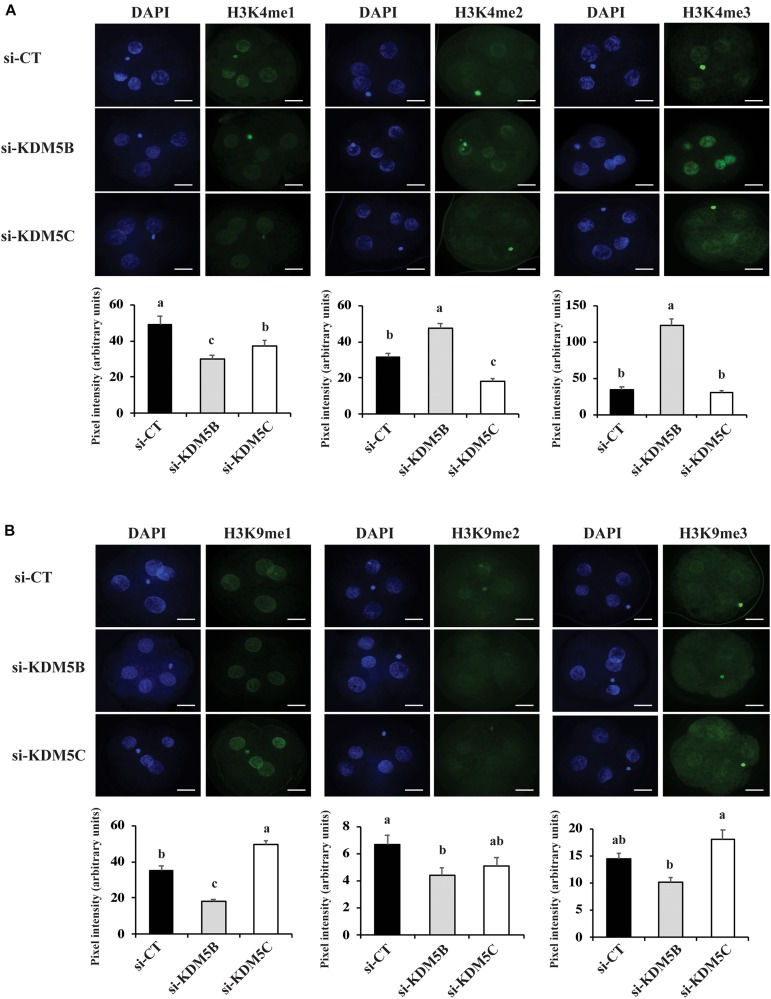
Detection of H3K4 and H3K9 methylation by immunofluorescence on Day 3 PA embryos derived from oocytes injected with si-CT, si-KDM5B or si-KDM5C. (A) Representative pictures and quantification of the pixel intensity for H3K4-me1, me2 and me3. (B) Representative pictures and quantification of the pixel intensity for H3K9-me1, me2, and me3. Three independent replicates were performed and 10–15 embryos were used to quantify pixel intensities for each epigenetic mark. Different letters indicate statistical significance between treatments for each epigenetic mark (P < 0.05). Scale bars represent 25 μm.